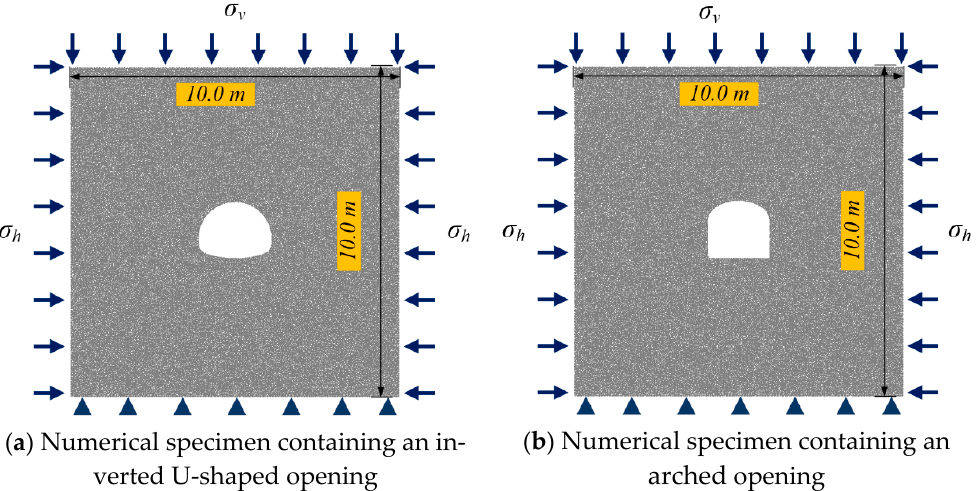
Figure 11. Numerical modelling of rock specimens containing an opening.